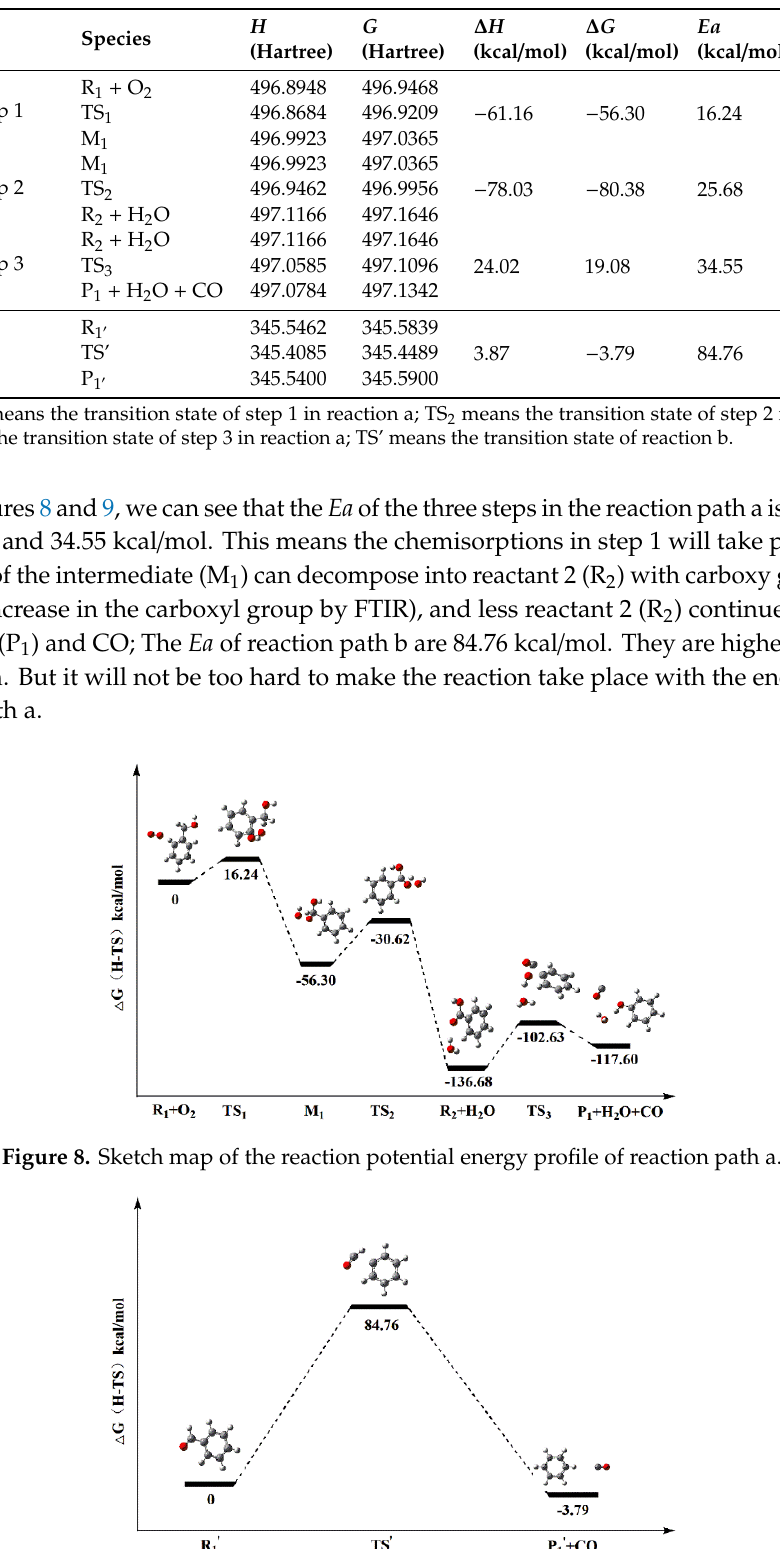
Table 3. Thermodynamic data of all species and activation energies of the reactions.